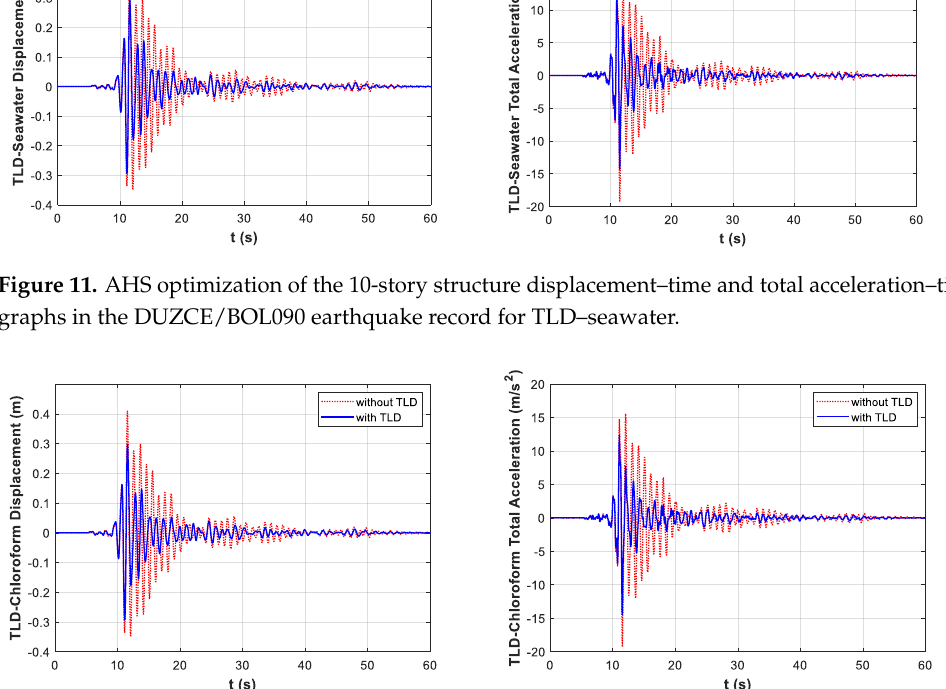
Figure 12. AHS optimization of the 10-story structure displacement–time and total acceleration–time graphs in the DUZCE/BOL090 earthquake record for TLD–chloroform.